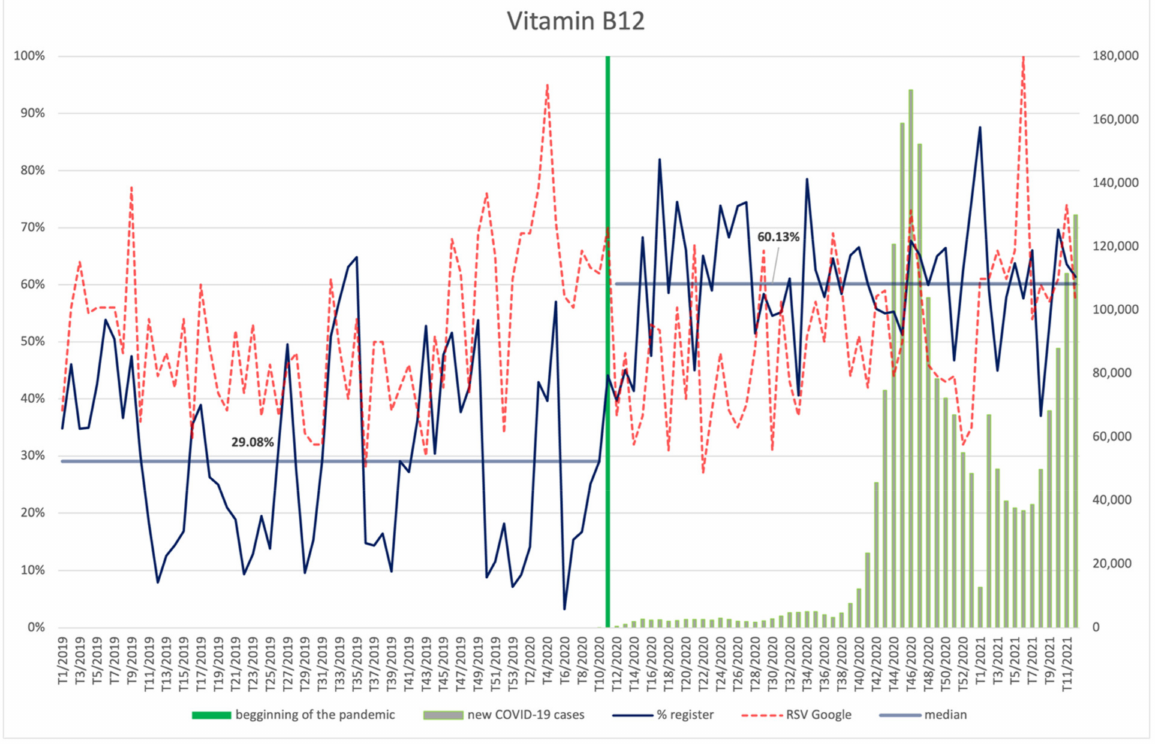
Figure 20. Comparison between the number of new registrations of products containing vitamin B12, the number of COVID-19 cases, and the frequency of search for information on the ingredient in the Google